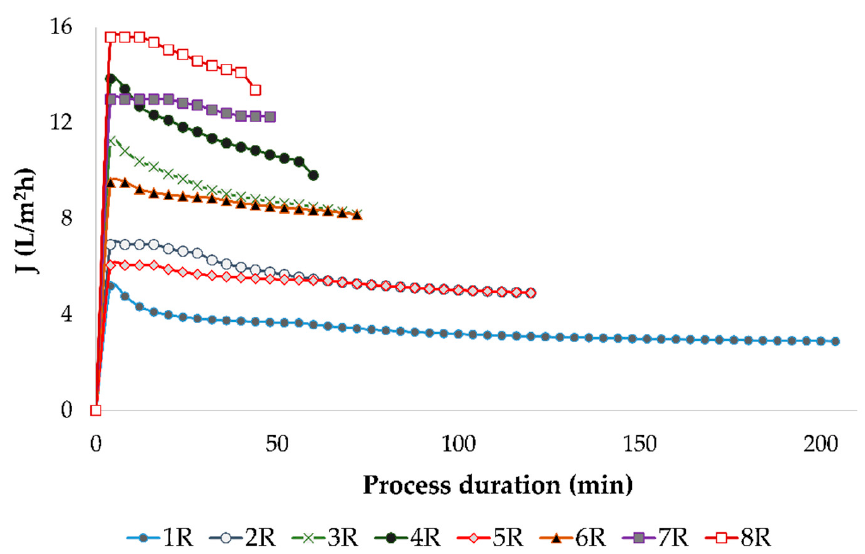
Figure 2. Permeate flux ( J ) decline during reverse osmosis process of conventional and ecological red wines at different processing parameters. Abbreviations: R—reverse osmosis process; 1—2.5 MPa with cooling; 2—3.5 MPa with cooling; 3—4.5 MPa with cooling; 4—5.5 MPa with cooling; 5— 2.5 MPa without cooling; 6—3.5 MPa without cooling; 7—4.5 MPa without cooling; 8—5.5 MPa without cooling.